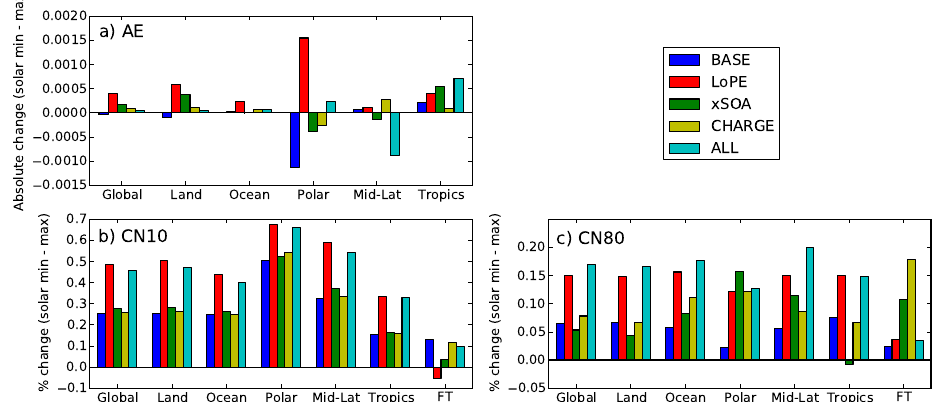
Fig. 8. Annual-average global changes between solar minimum and solar maximum. (a) Absolute change in column Angstrom Exponent, and percent change in (b) CN10 and (c) CN80 for the various sensitivity studies (colors) and locations. For CN10 and CN80, “Global” through “Tropics” refer to surface concentrations, and FT is the global free